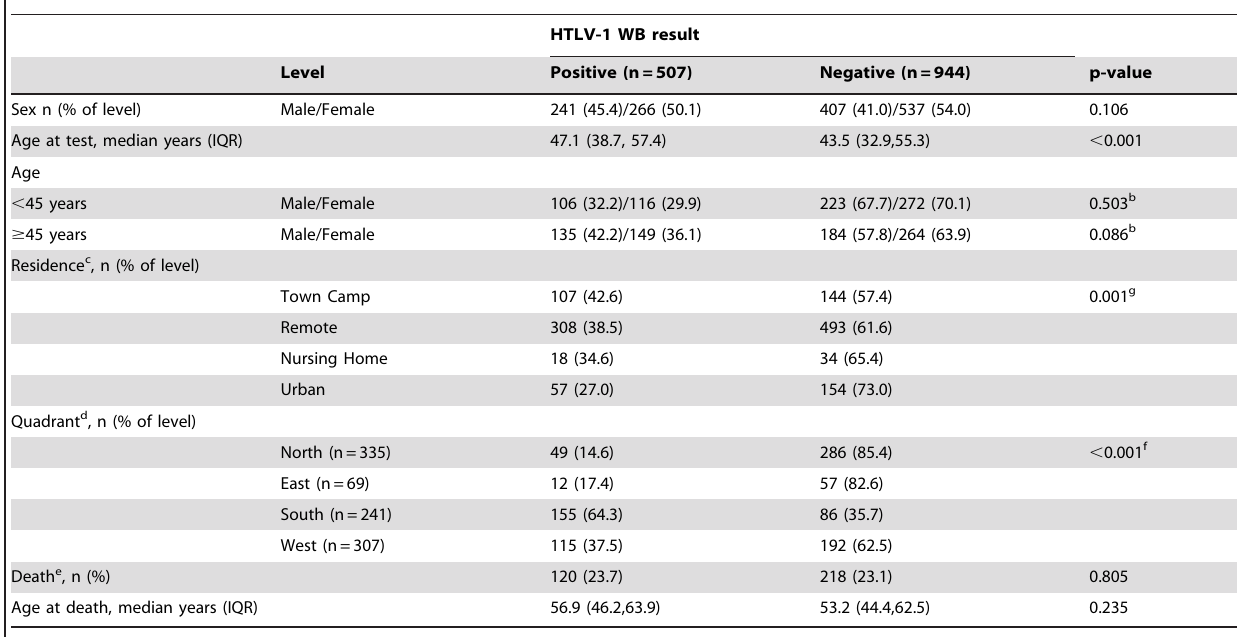
Table 1. Patient characteristics for 1451 Indigenous Adults admitted 2005–2010 a